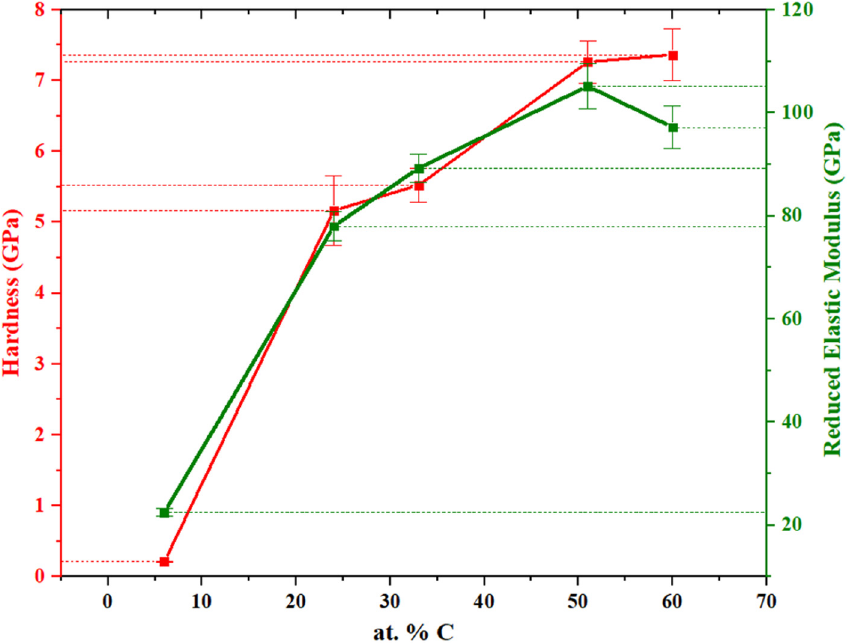
Figure 5. Results from nanoindentation experiments: hardness and reduced elastic modulus for each carbon content respectively.